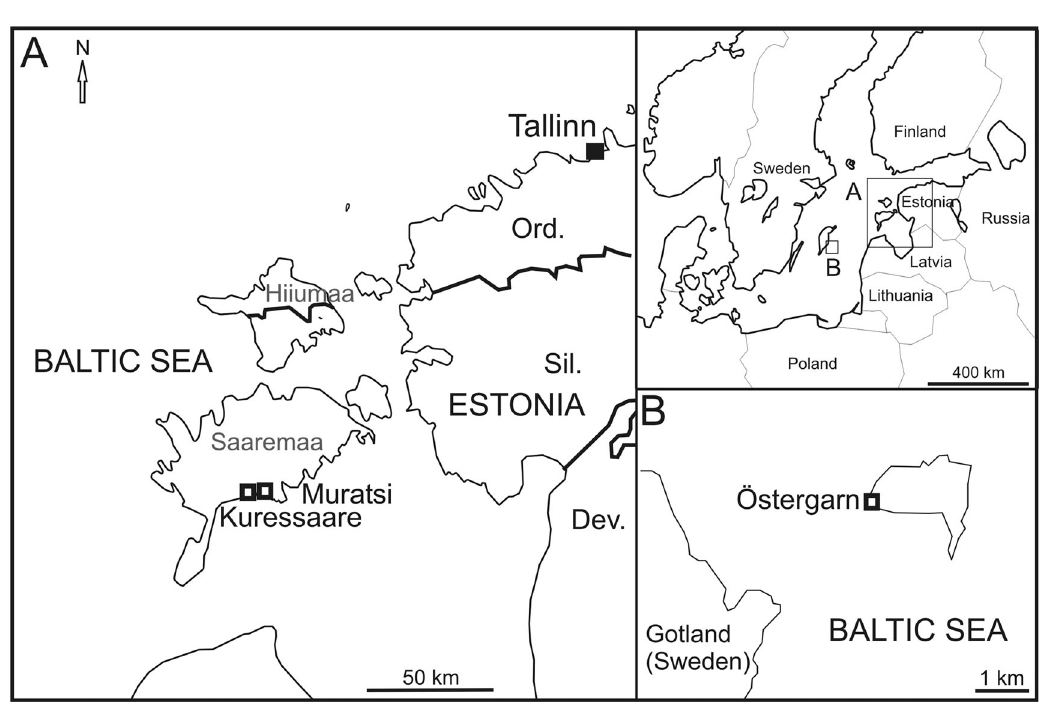
Fig. 1. Sketch map of the Baltic region showing the sampled localities of Saaremaa Island, Estonia ( A ) and Östergarn, Gotland, Sweden ( B ). Ord., Ordovician; Sil., Silurian; Dev., Devonian.